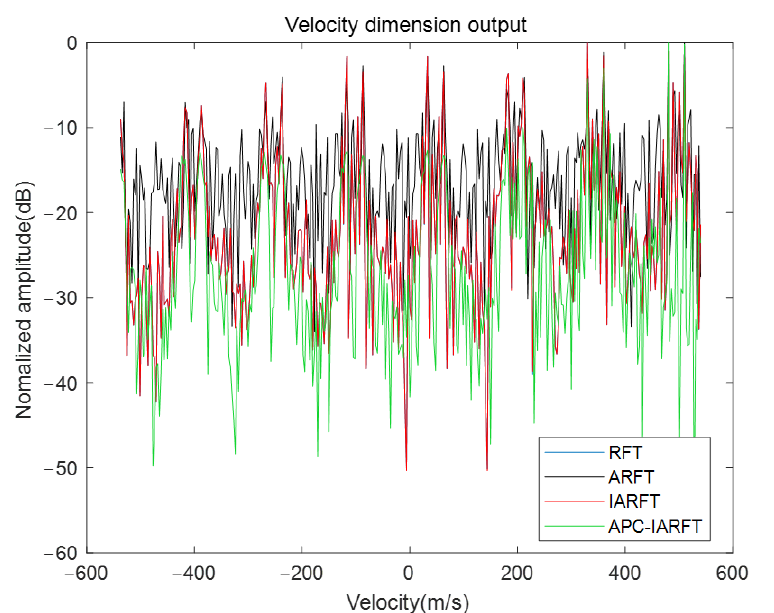
Figure 12. Plan output of four methods in Scenario 3.